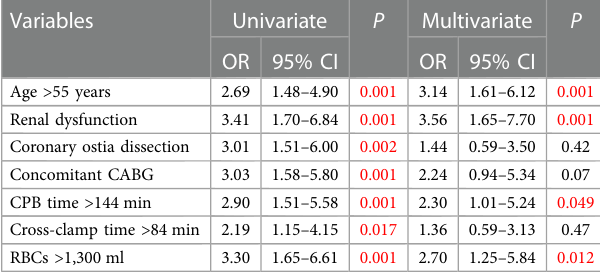
TABLE 5 Univariate and multivariable logistic regression analysis for in-hospital death risk factors in patients with ATAAD.